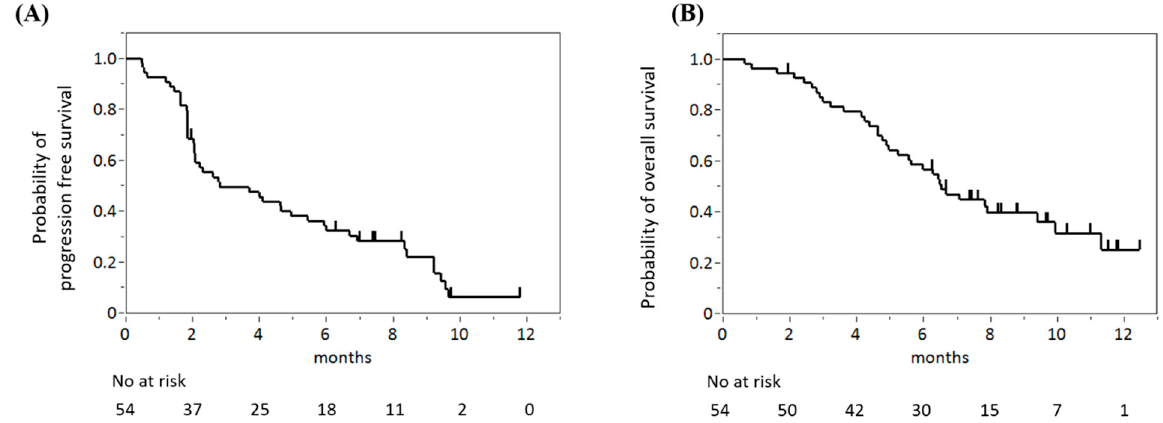
Figure 1. Progression-free survival ( A ) and overall survival ( B ) of all analyzed patients. Table 2. Tumor response in patients with evaluable target lesions.